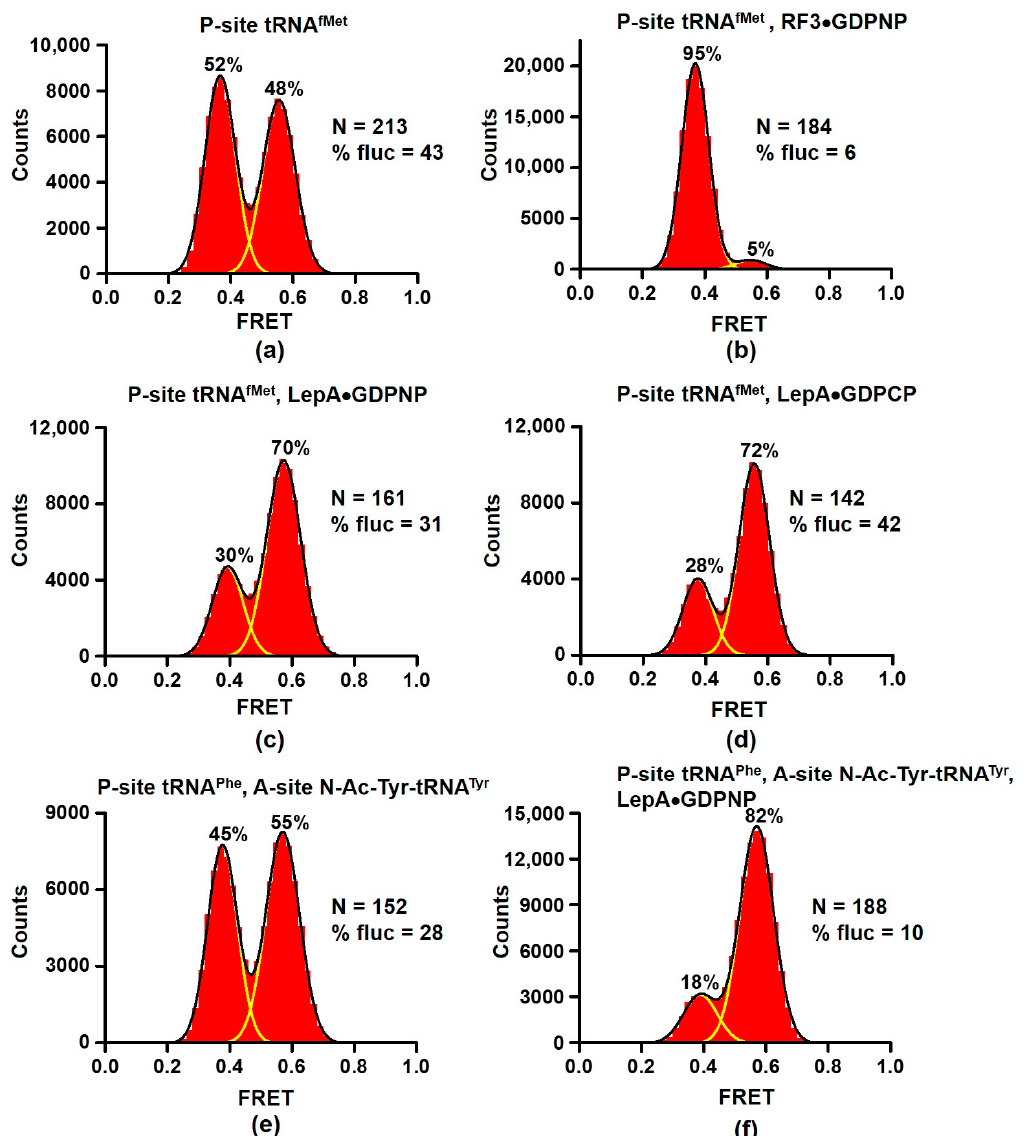
Figure 1. LepA stabilizes the non-rotated conformation of the ribosome. Histograms show FRET distribution in S6-Cy5/L9-Cy3 ribosomes. Ribosomes bound with P-site deacylated tRNA fMet ( a – d ) were incubated with RF3 • GDPNP ( b ) or LepA • GDPNP (c) or LepA • GDPCP ( d ). Ribosomes bound with P-site deacylated tRNA Phe and A-site N-Ac-Tyr-tRNA Tyr ( e , f ) were incubated with LepA • GDPNP ( f ). N indicates the total number of FRET traces compiled into each histogram. % fluc designates the percentage of traces that show fluctuations. Yellow lines show individual Gaussian fits. Black line indicates the sum of Gaussian fits. The fraction of the ribosomes in the R and NR conformations are shown above the corresponding 0.37 and 0.56 Gaussian peaks.